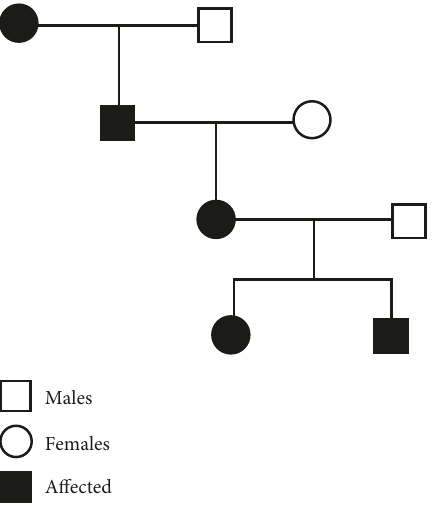
Figure 15: Pedigree of the family affected by